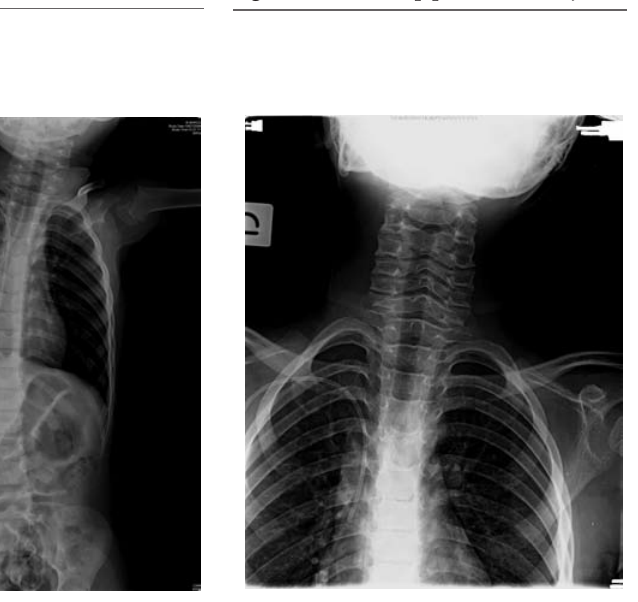
Figure 1. Case #1. Initial tip position. Figure 2. Case #1. Tip position after 6 years.